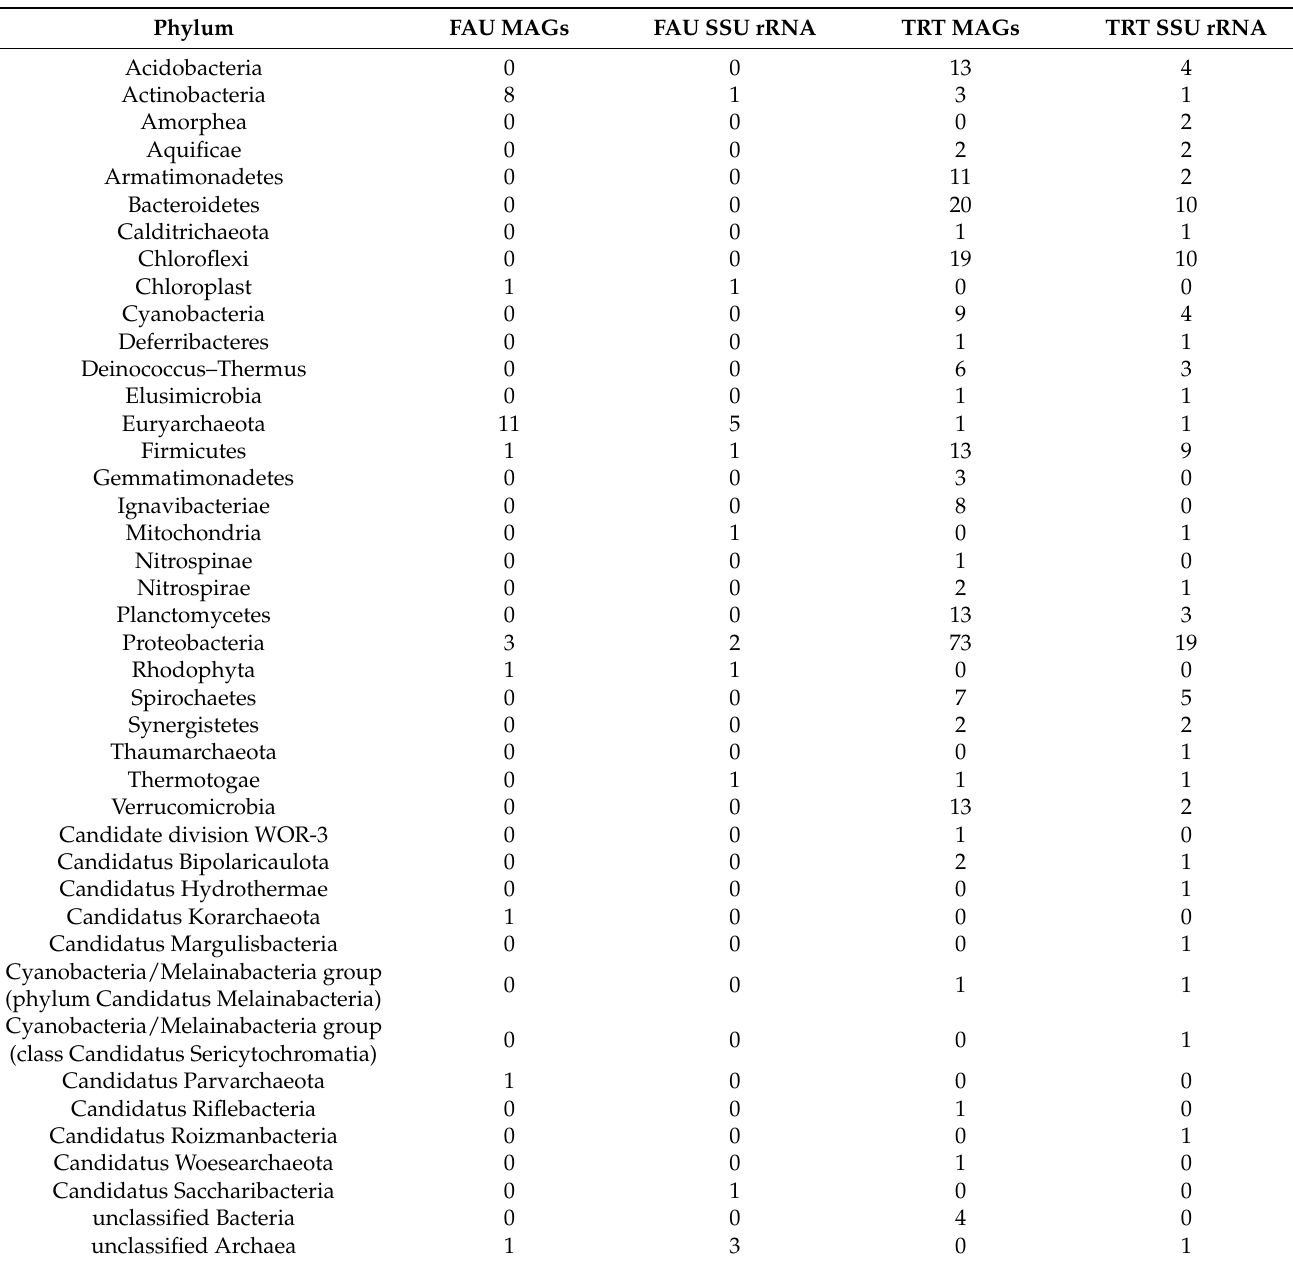
Table 3. The number of MAGs with completeness > 75%, contamination < 5%, assembled 16S rRNAs >1 kbp long, and with identity >90% obtained for FAU and TRT.